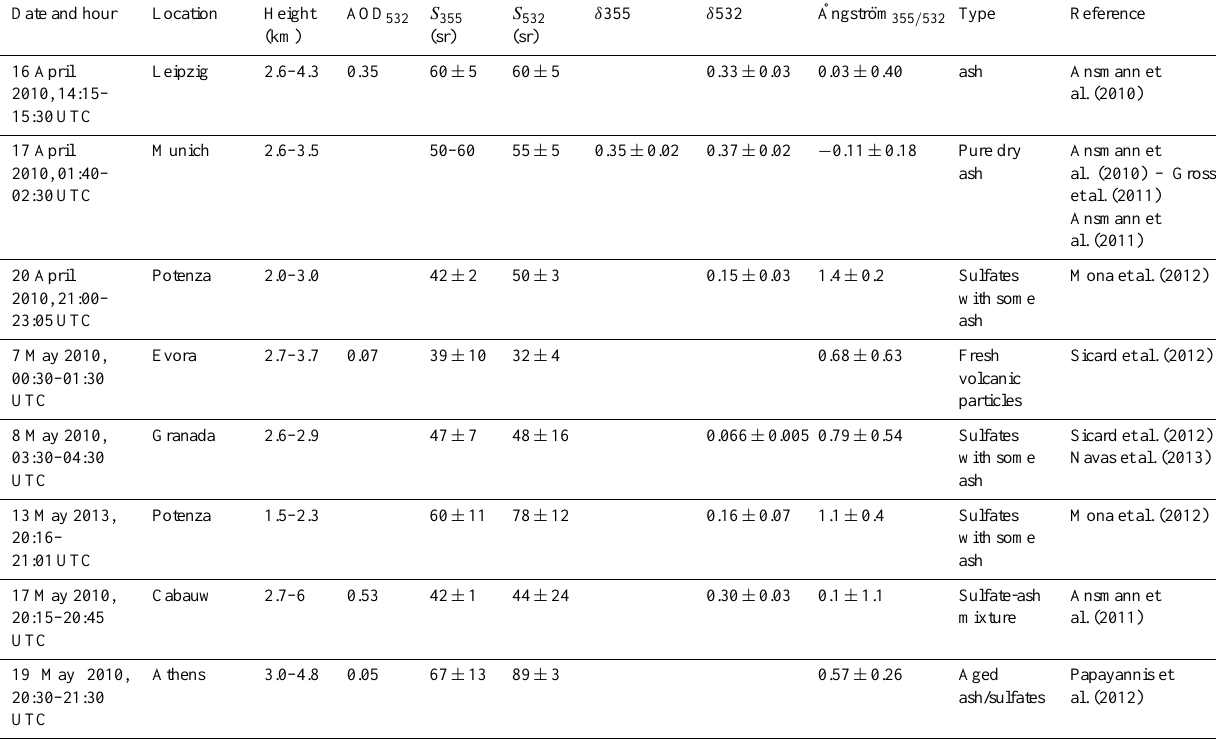
Table 3. Values for geometrical properties and optical properties (aerosol optical depth (AOD), lidar ratio ( S ), linear particle depolarization ratio ( δ) , and ˚Angstr¨om exponent) observed from specific EARLINET multi-wavelength Raman lidar stations in specific periods of the Eyjafjallaj¨okull eruption (April–May 2010). The table reports also the retrieved volcanic aerosol type with corresponding